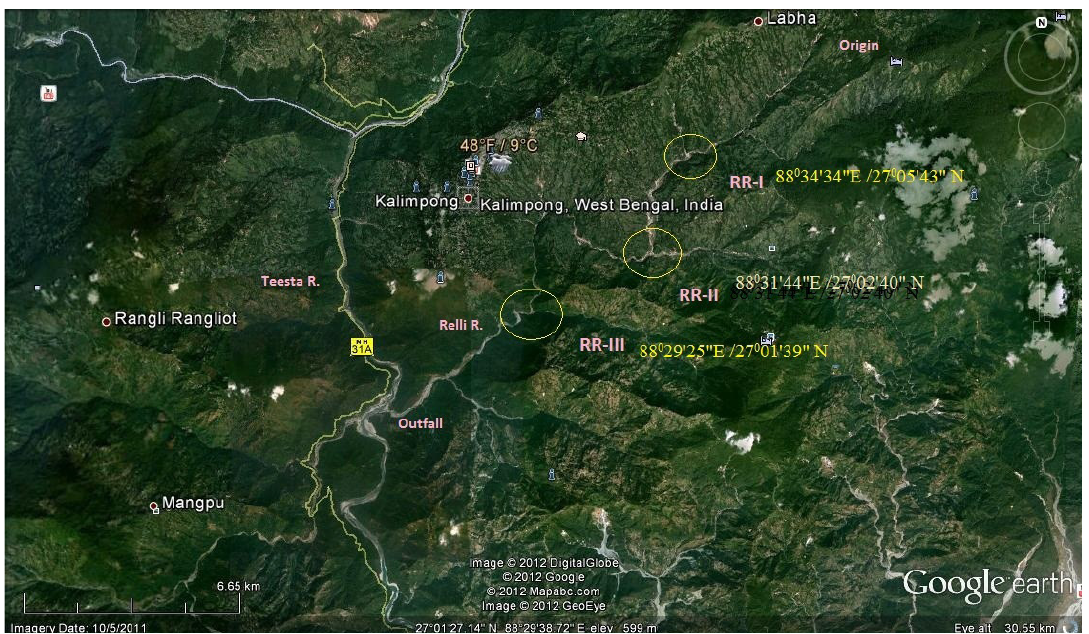
Figure 1. Study area and sampling sites in the hill stream Relli (Courtesy-Google Earth).